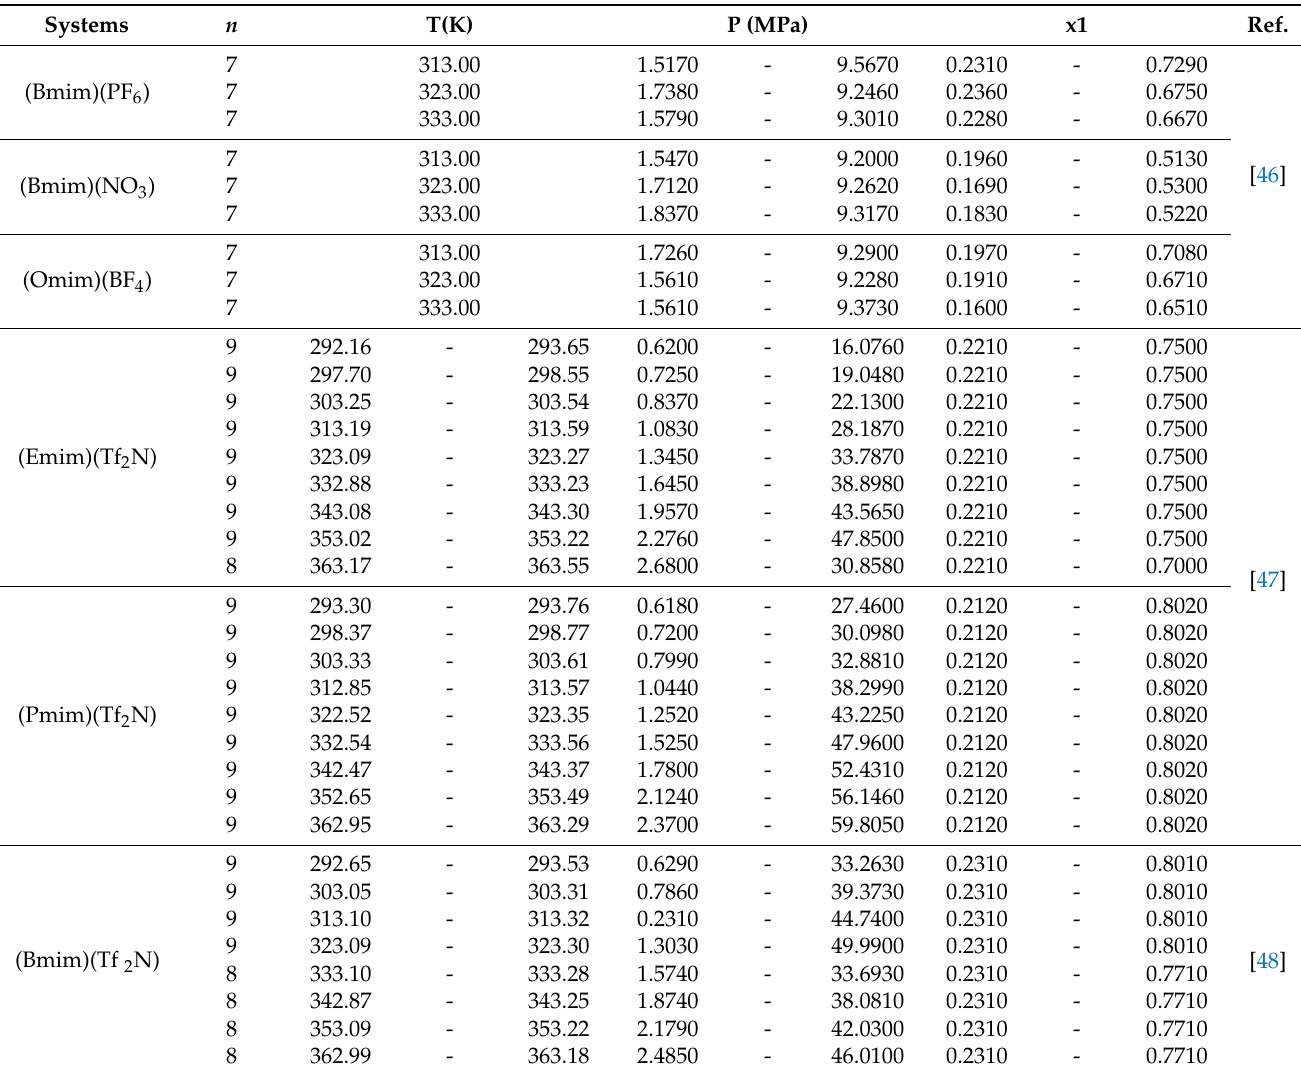
Table 2. All the data considered in this